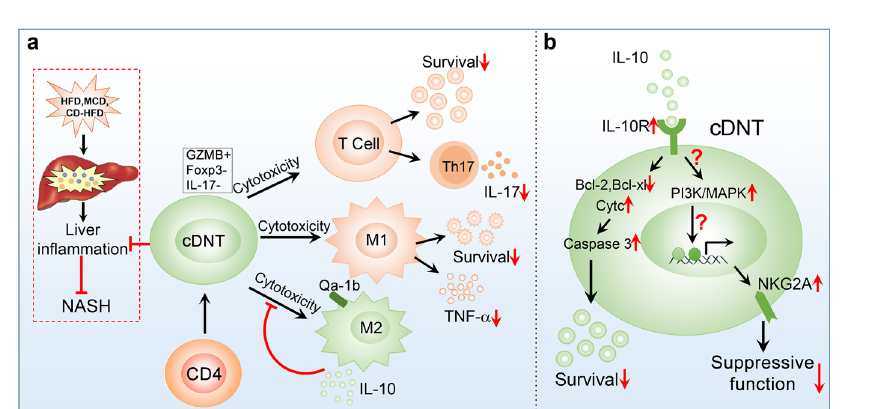
Fig. 8 Mechanisms by which transferred cDNT regulate the liver immune microenvironment and inhibit liver in fl ammation during NASH development. a The transferred cDNT not only decreased CD4 + T cell proportion and survival and Th17 cell differentiation, but also selectively suppressed the proportion and cytokine production of liver-in fi ltrating M1, but not M2 macrophages. IL-10 secreted by M2 macrophages downregulated the immunosuppressive function of cDNT toward M2 macrophages. b The IL-10/IL-10R interaction could decrease Bcl-2 and Bcl-xL expression, and enhance cytochrome C leakage and caspase-3 activity, leading to decreased cDNT survival. The IL-10/IL-10R interaction also activates the PI3K/MAPK signaling pathway, which might induce the expression of the inhibitory receptor NKG2A. The inhibition of cDNT survival and the promotion of NKG2A expression by the IL-10/IL-10R interaction contribute to decreasing cDNT other data supporting the fi ndings of this study are available within the article and its Supplementary Information fi les, and from the corresponding author upon reasonable request. Source data are provided with this paper.